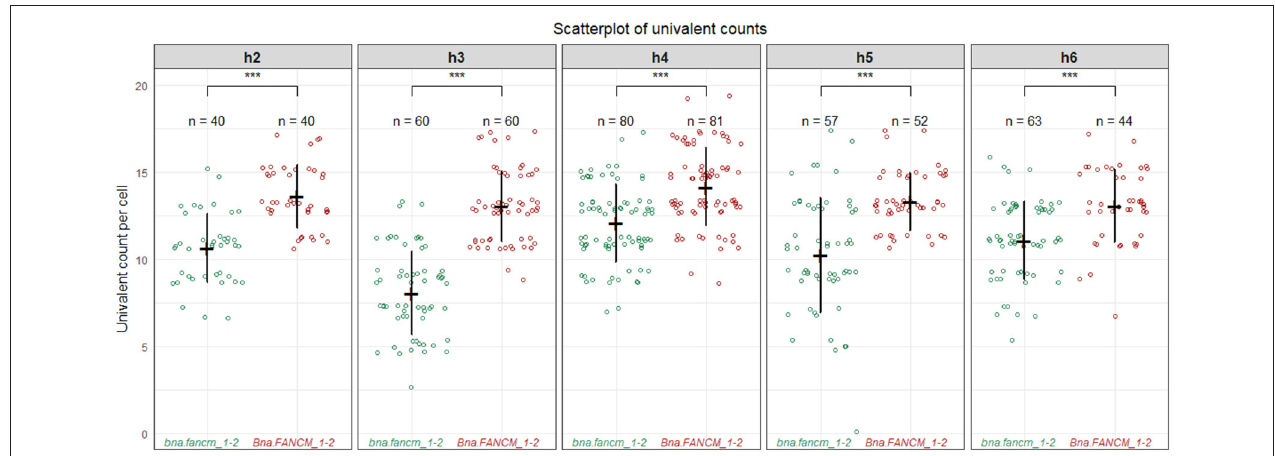
FIGURE 3 | Homoeologous crossovers in fancm allohaploids plants. Boxplot for the number of univalents between mutants and WT allohaploids derived from five heterozygous F1 plants combining bnaA.fancm-1 with bnaC.fancm-2 (h2–h6). At least 2 mutants and 2 WT allohaploids plants were derived per F1 hybrids and were used as replicates. Around 20 meiocytes have been observed per replicate and the counts per replicate were pooled together. *** P < 0.001, Wilcoxon Signed-Rank